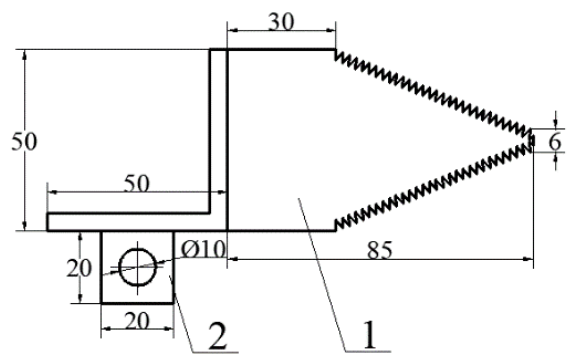
Fig. 4. Moving cutter structure and distribution